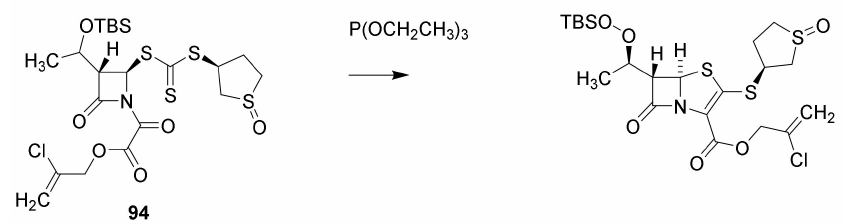
Scheme 10. Formation of the thipenem skeleton